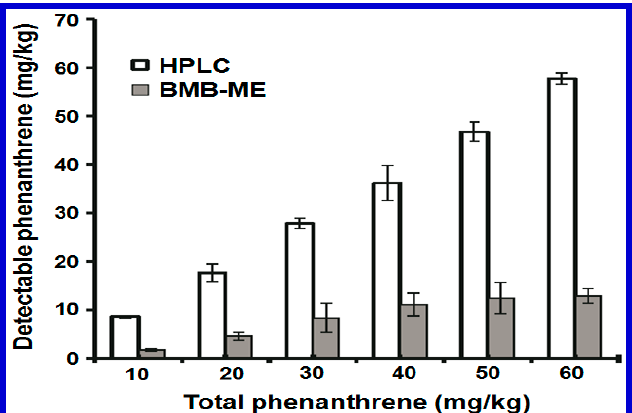
Figure 2. A comparison of the PHE concentrations detected using a HPLC or using a BMB-PL whole cell biosensor approach is given. The values represent the mean ± standard error ( n = 3) for the fluorescence and bioluminescence detected. Reprinted with permission from [26].